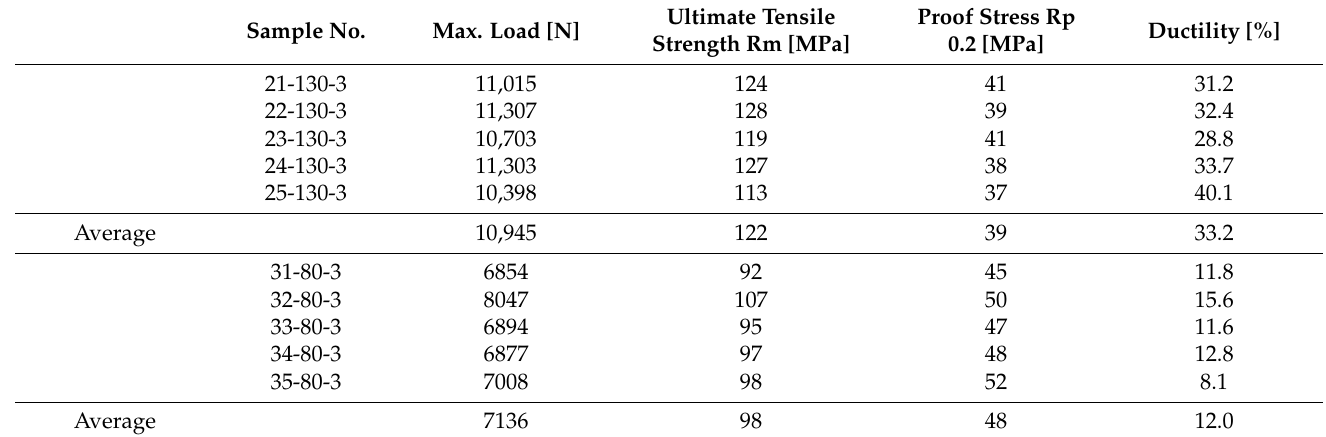
Table 4. Average values of mechanical parameters of samples with integrated RFID tag type no. 3. Sample